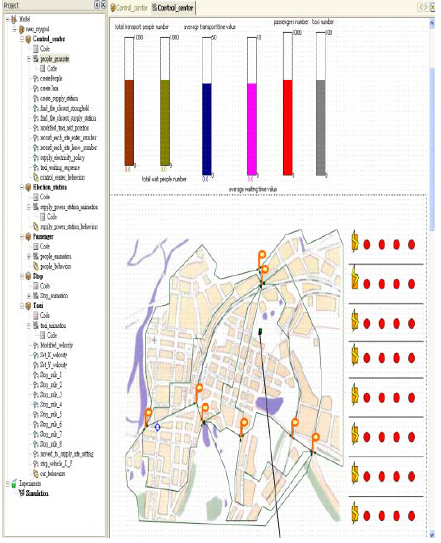
Figure 14. “Electric-taxi DAR operation simulation